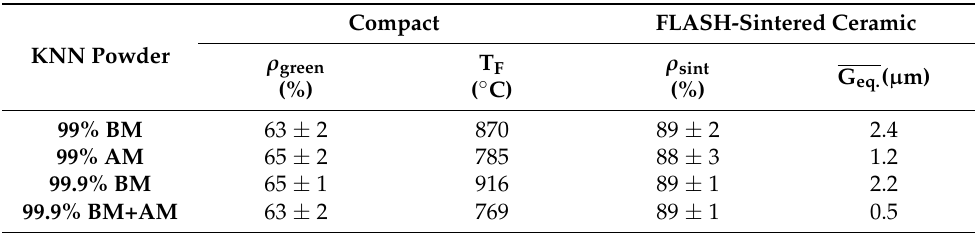
Table 4. FLASH temperature (T F ), relative densities—green ( ρ green ) and after sintering ( ρ sint )—and mean grain size (G eq.